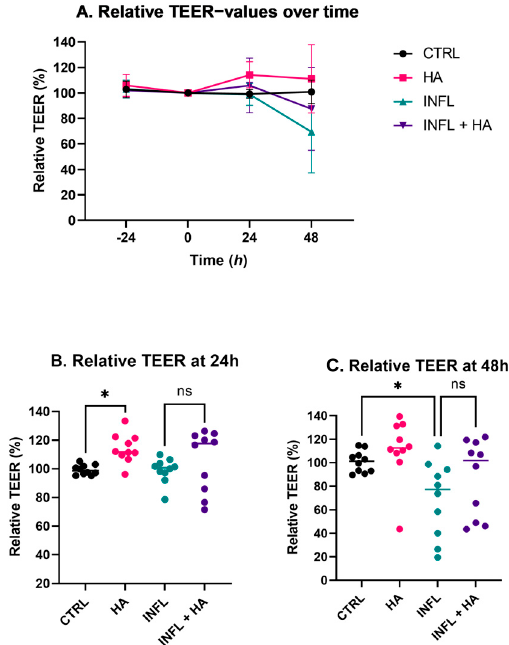
Figure 1. Relative TEER values comparing the mean measurements of duplicate measurements to the mean of each baseline measurement at 0 h. ( A ) Relative TEER over time compared to 0 h ( n = 10), including means and SD. ( B ) Relative TEER at 24 h ( n = 10), including results of the Friedman test (* p < 0.05; ns = not significant). ( C ) Relative TEER at 48 h ( n = 10), including results of the Friedman test (* p < 0.05; ns = not significant). CTRL = Control medium, INFL = Control medium and inflammatory mix, HA = medium containing 100 mM acetate, INFL + HA = medium containing 100 mM acetate and inflammatory mix.